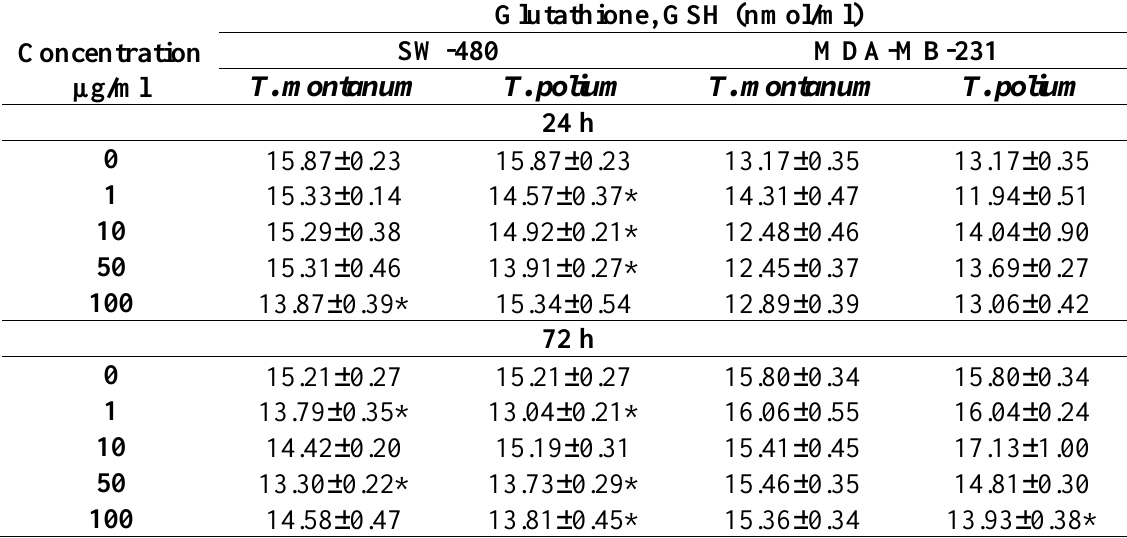
Table 3. Effects of methanolic extracts of Teucrium montanum and T. polium on SW-480 and MDA- MB-231 cell lines, expressed as the GSH concentration after 24 h and 72 h of exposure. *p < 0.05 as compared to the control